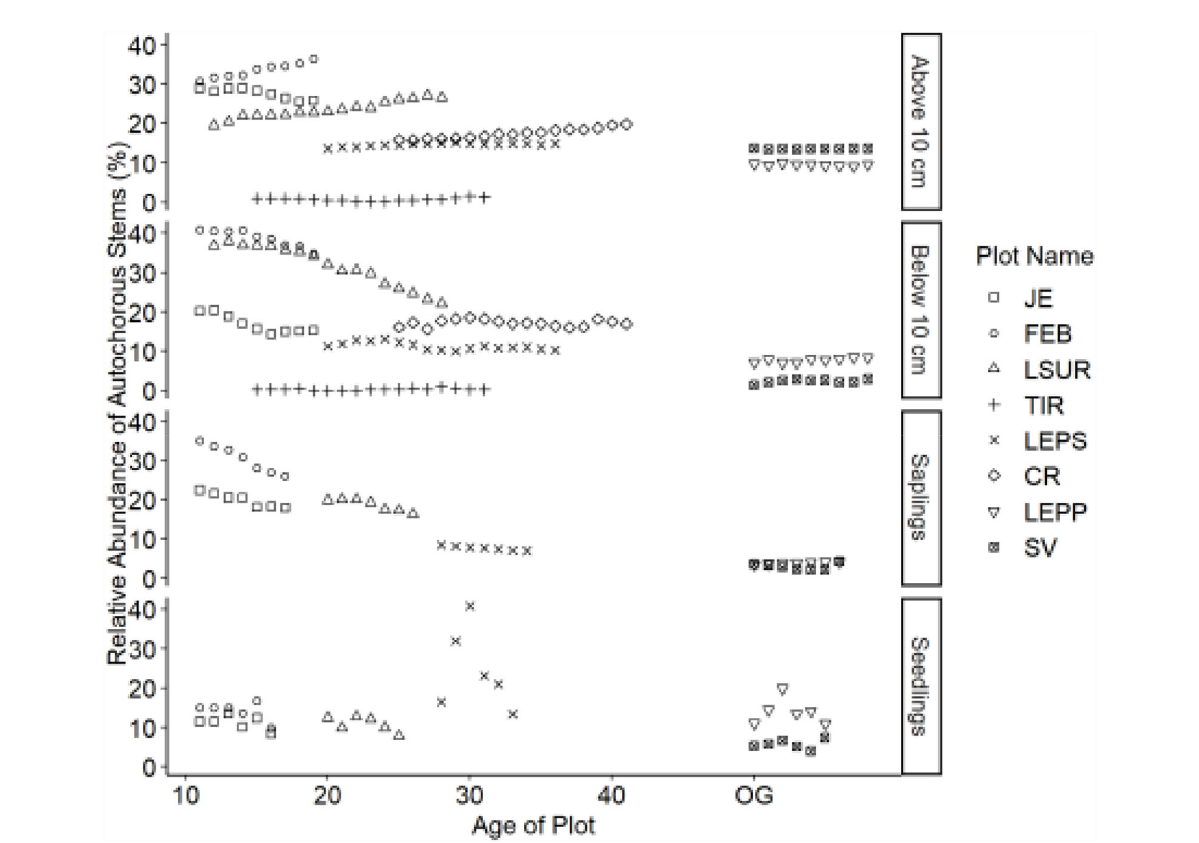
FIGURE4 Relative abundance of autochorous stems. Table 1 indicates the plot acronyms, which appear from youngest to oldest, top to bottom in the legend.